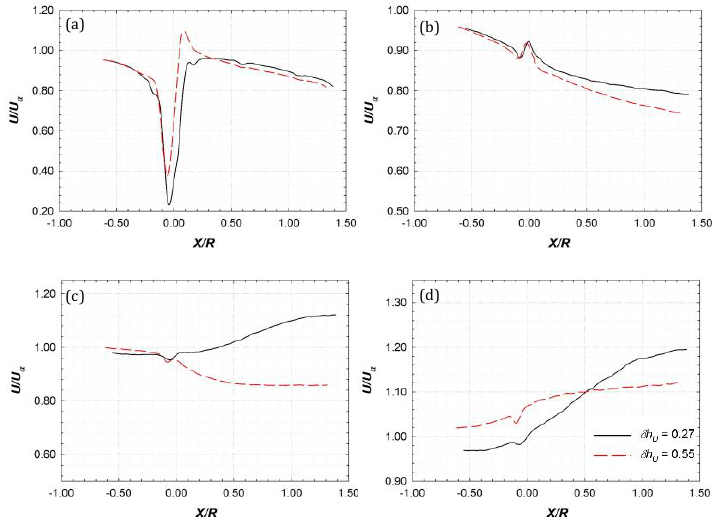
Figure 7. Variation of normalized stream-wise velocities of the upper-wake bypass region for a rotational velocity of 180 RPM and tip clearance ratios of 0.55 and 0.27 on horizontal lines at depths of ( a ) Y/ R = 0, ( b ) Y/ R = 0.5, ( c ) Y/ R = 1, and ( d ) Y/ R = 1.3.